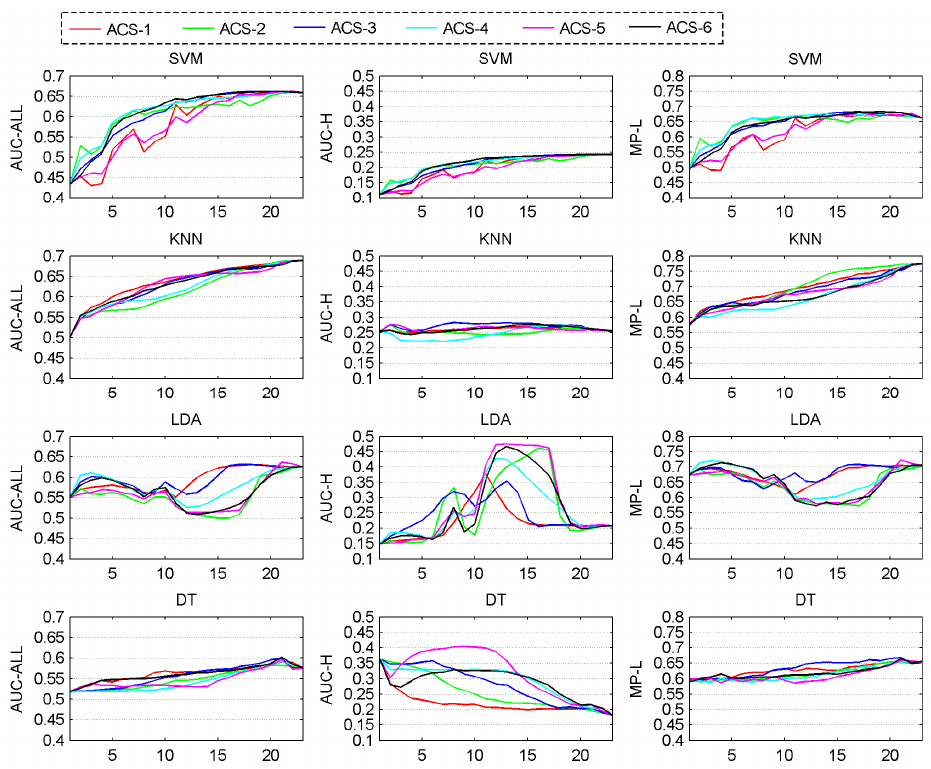
Figure 5. Graphs of performance evolving over iterations (horizontal axis) of ACS methods with SVM, KNN, LDA and DT classifier. AUC-ALL, AUC-H and MP-L are the measures of overall performance, high-TPR performance and sorting performance, respectively.